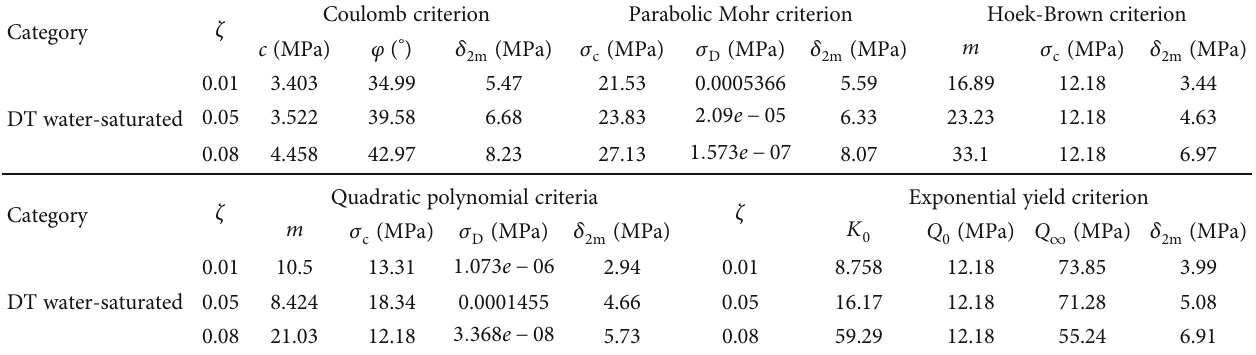
Table 4: Triaxial strength fi tting results of fi ve e ff ective yield criteria for saturated coal based on the least absolute deviation. Coulomb Category ζ